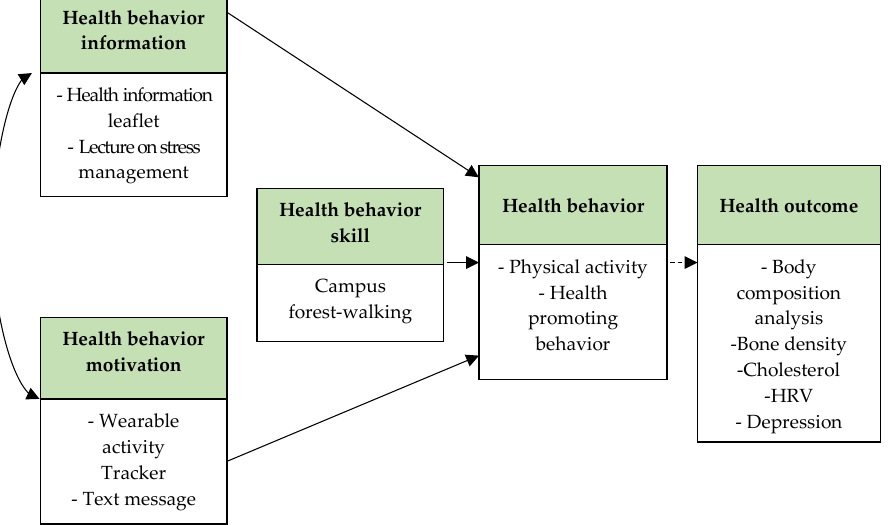
Figure 2. The conceptual model of the campus forest-walking program